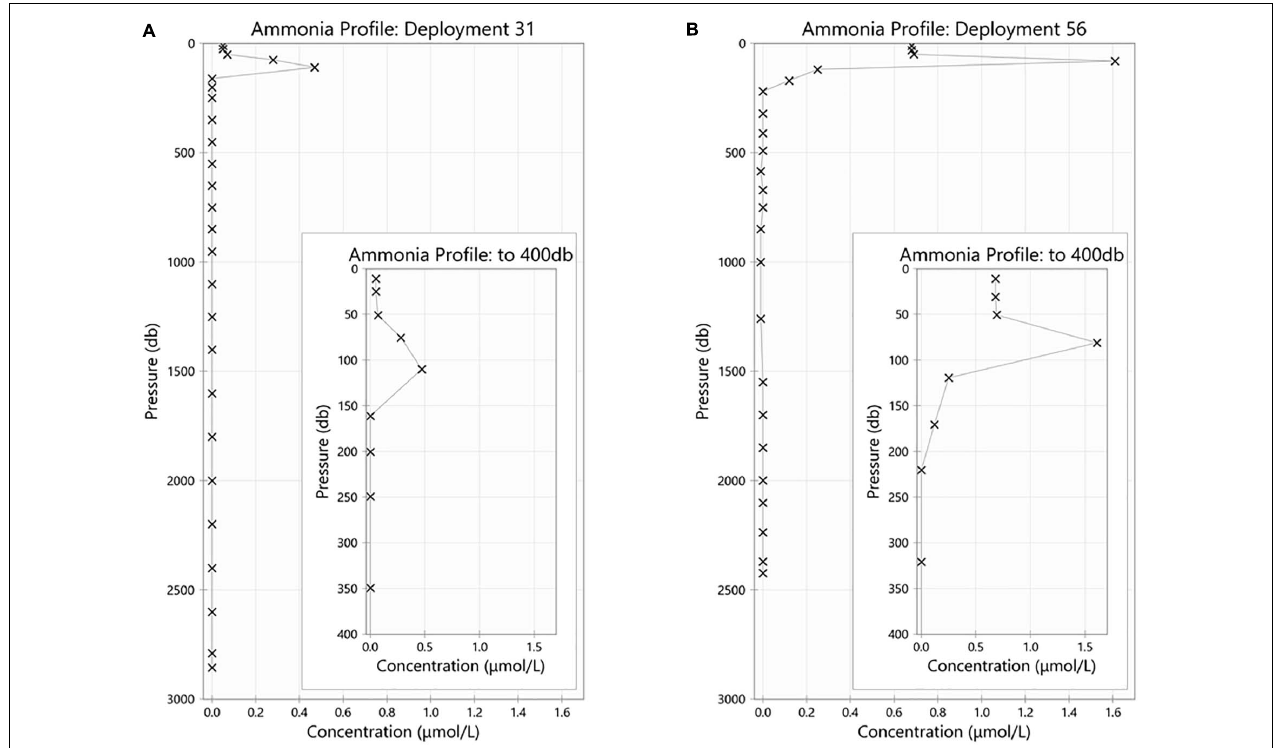
FIGURE 6 | Ammonium (in µ mol/L) profiles for CTD station (A) 31 and (B) 56. For both profile, the internal panel represents a magnification of the upper 400 m.